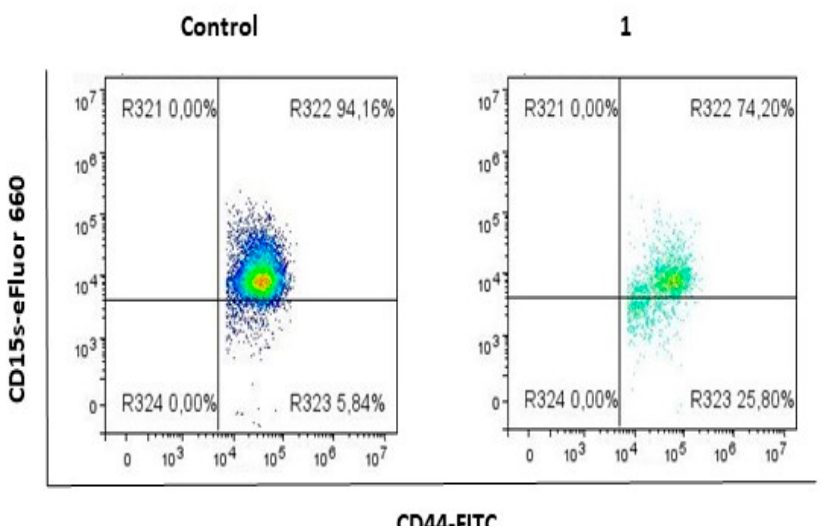
Figure 3. Expression of CD15s in CSC subpopulation after treatment with compound 1 . Notes: R321- CD15 + CD44 − cells; R322- CD15s + CD44 + cells; R323- CD15s − CD44 + cells; R324- CD15s − CD44 − . Abbre-